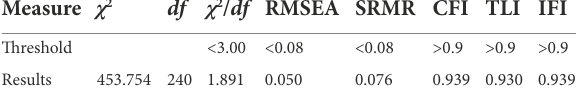
TABLE 11 The test for the mediating effects.